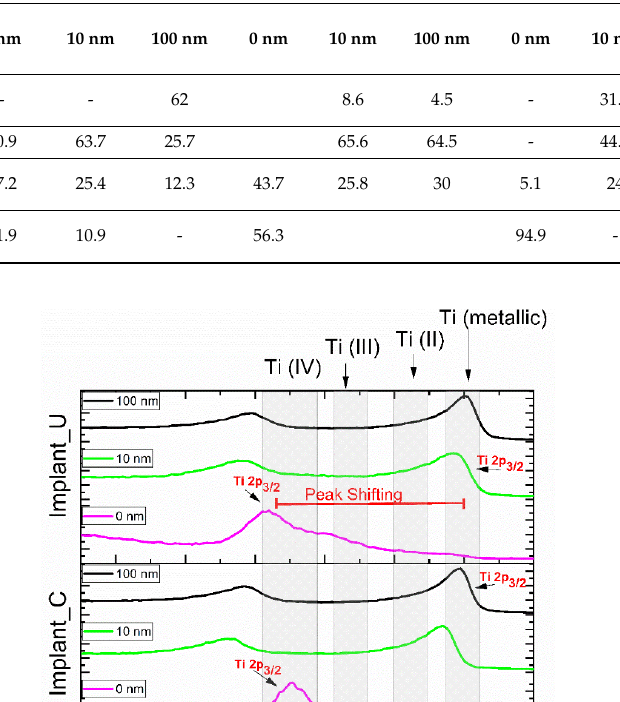
Table 2. High-resolution XPS results: atomic percentage of the Ti 2p peak contribution (%).